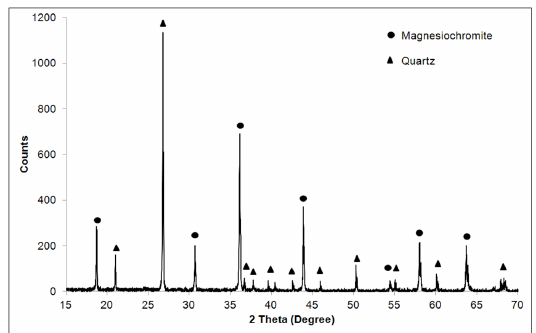
Figure I. XRD pattern of the A1 filler